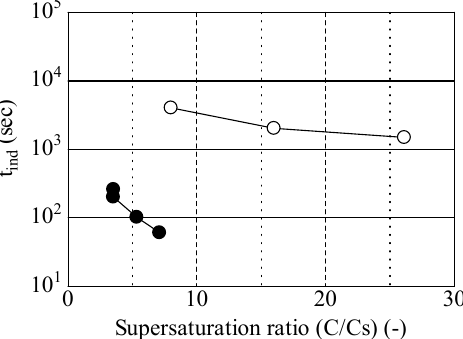
Figure 12. Induction period, t ind , in the cooling and poor solvent crystallization at 25°C.